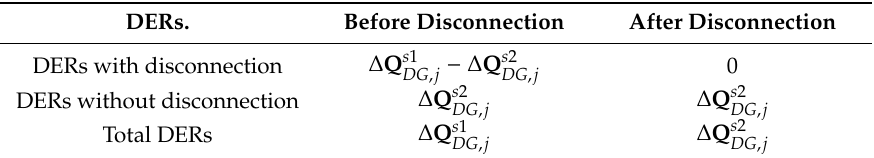
Table 1. Reactive power generations before and after disconnection.